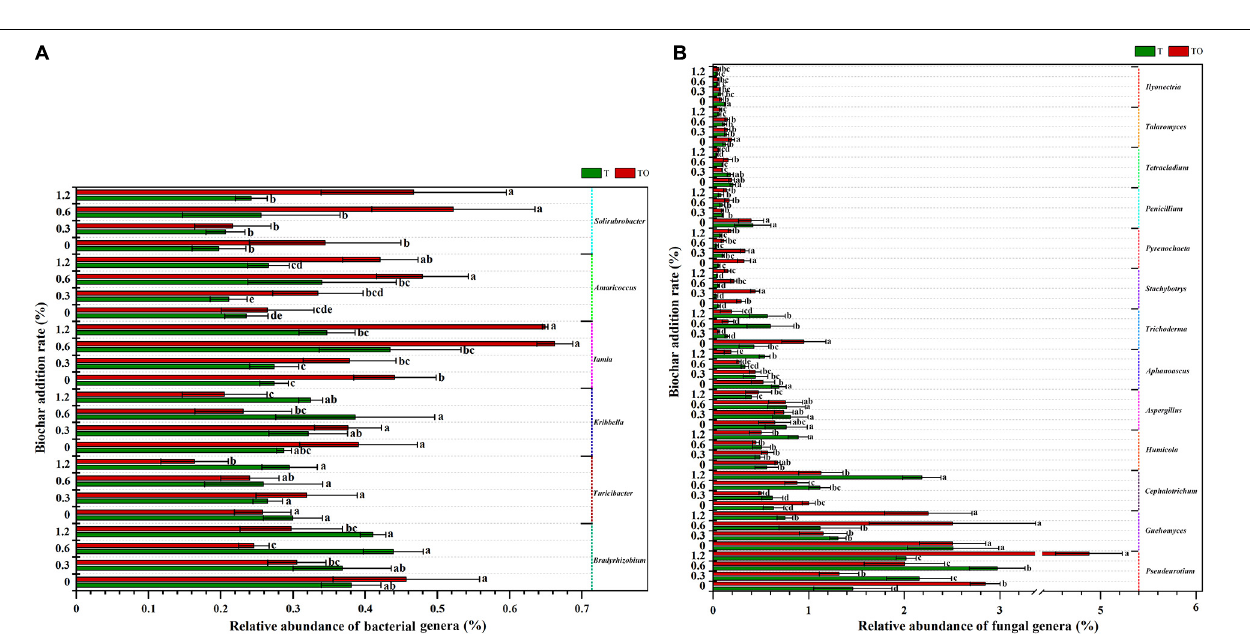
FIGURE 4 | The relative abundances of bacteria (A) and fungi (B) phylum on tomato rhizosphere soil after 30 days pot experiment in 2019. T and TO indicate tomato monoculture and intercropped with potato–onion, respectively. 0, 0.3, 0.6, and 1.2% indicate the biochar rates.